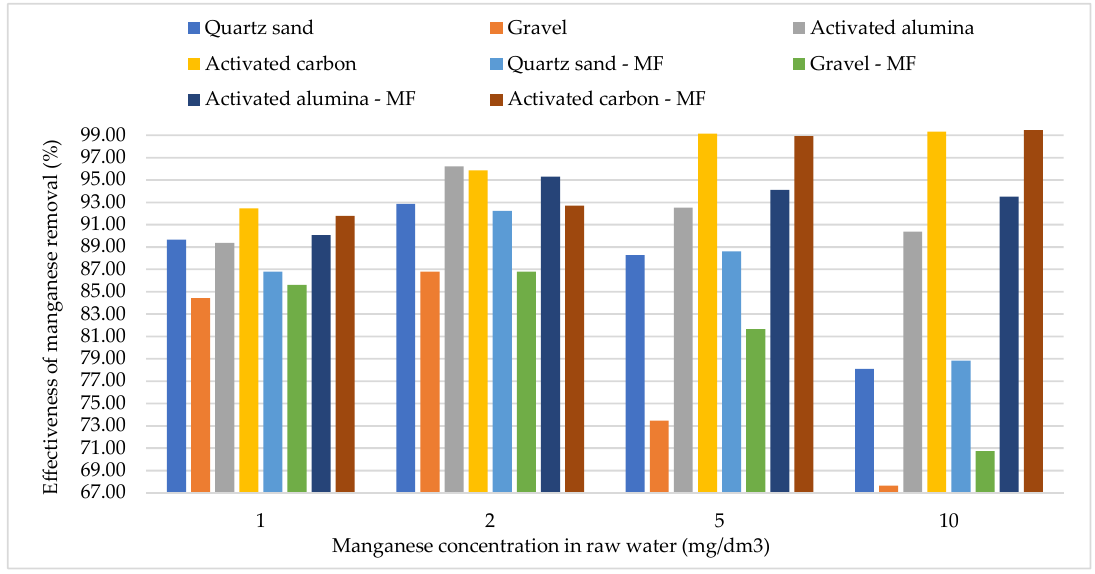
Figure 3. Dependence of the manganese removal efficiency on initial concentration in raw water.